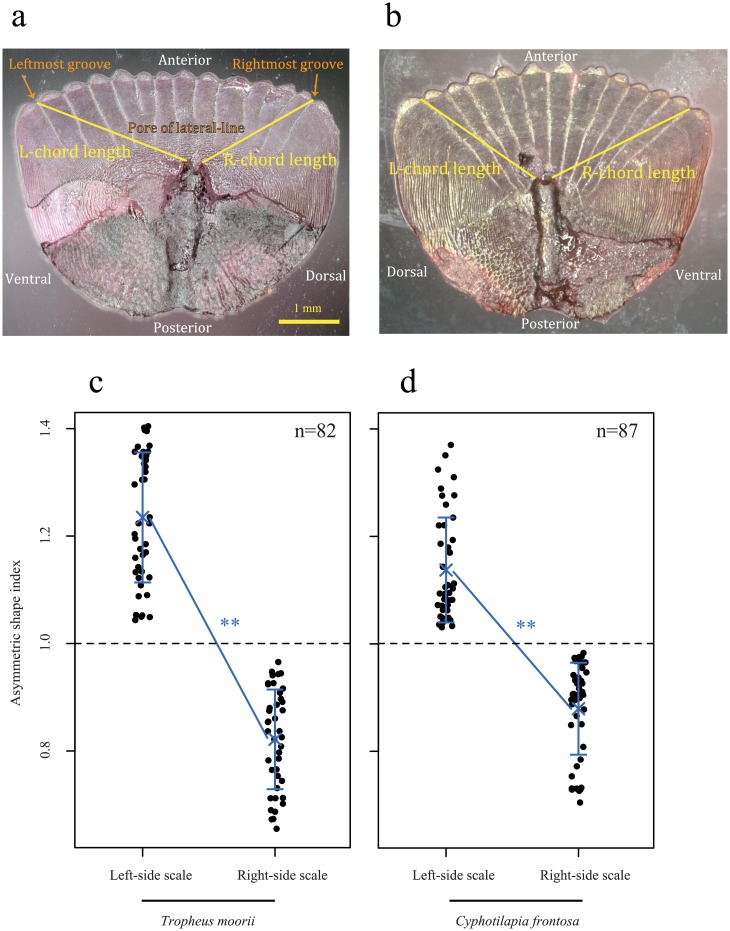
Assessment of behavioral laterality in predation.Pored scales from left (a) and right flanks (b) of a Cyphotilapia frontosa. Ratio of L- to R-chord length (L/R) accurately predicts which flank the scale originated from. The L/R value of left and right side scales in c, T. moorii (82 scales, 58–64mm SL (n = 3)), and d, C. frontosa (87 scales, 75–110mm SL (n = 3)). The cross and bars indicate the mean and standard deviation, respectively. P-values are from the Wilcoxon rank sum test. **P< 0.01.